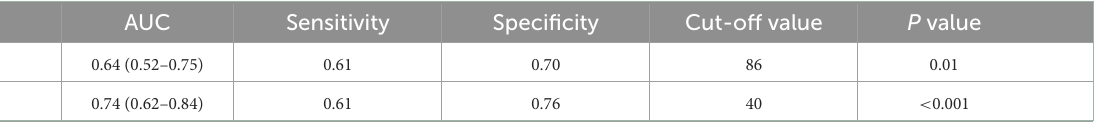
TABLE 3 ROC analysis of the cut-off value of MLS.